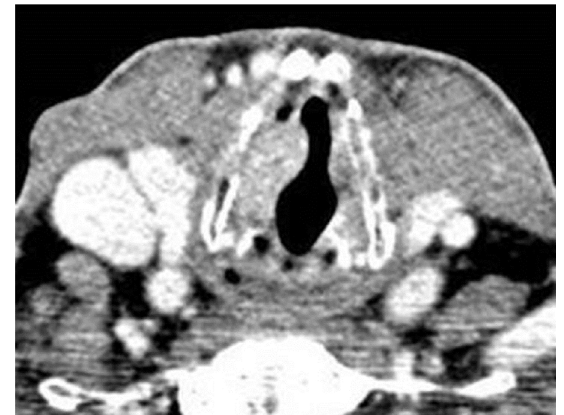
Figure 4 Indirect laryngoscopy at 12 months after